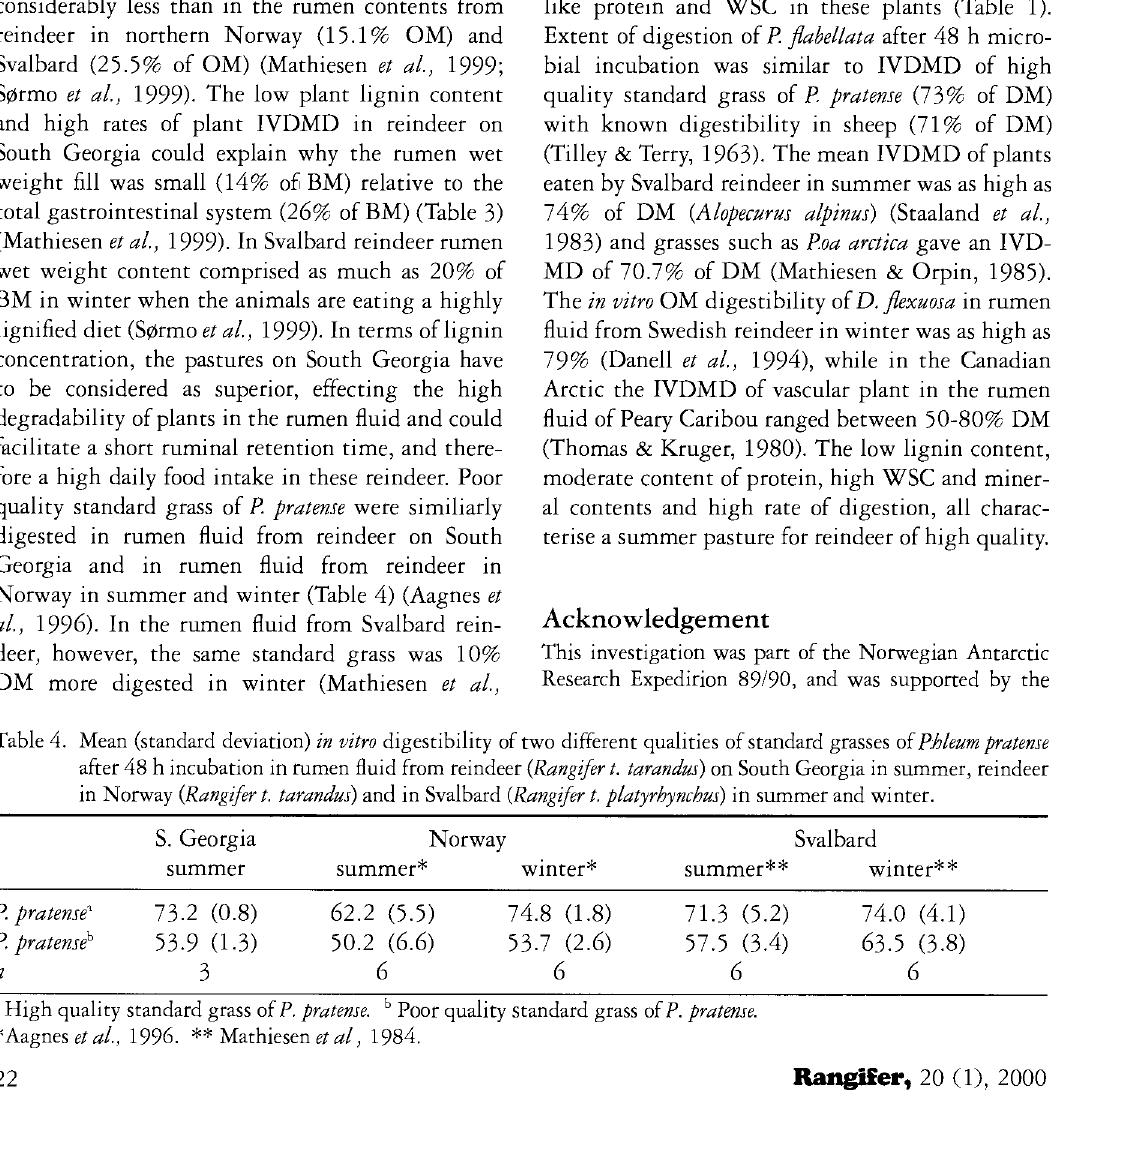
Table 4. Mean (standard deviation) in vitro digestibility of two different qualities of standard grasses of Phleum pratense after 48 h incubation in rumen fluid from reindeer (Rangifer t. tarandus) on South Georgia in summer, reindeer in Norway (Rangifer t. tarandus) and in Svalbard {Rangifer t. platyrhynchus) in summer and